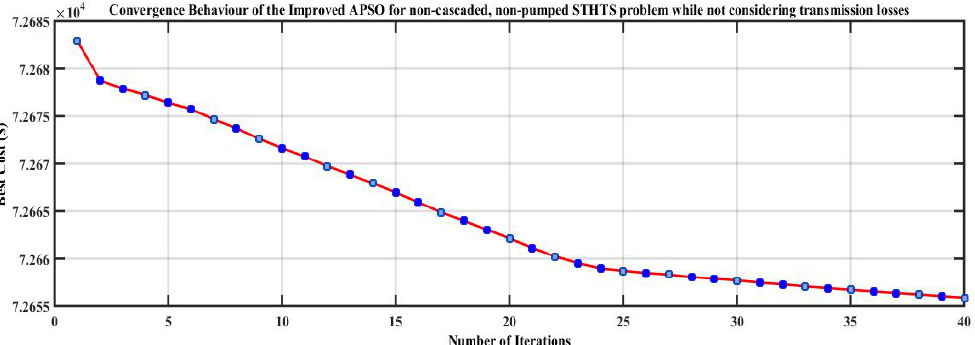
Figure 12. Convergence characteristics of the improved APSO algorithm on the non-cascaded non-pumped STHTS problem without transmission